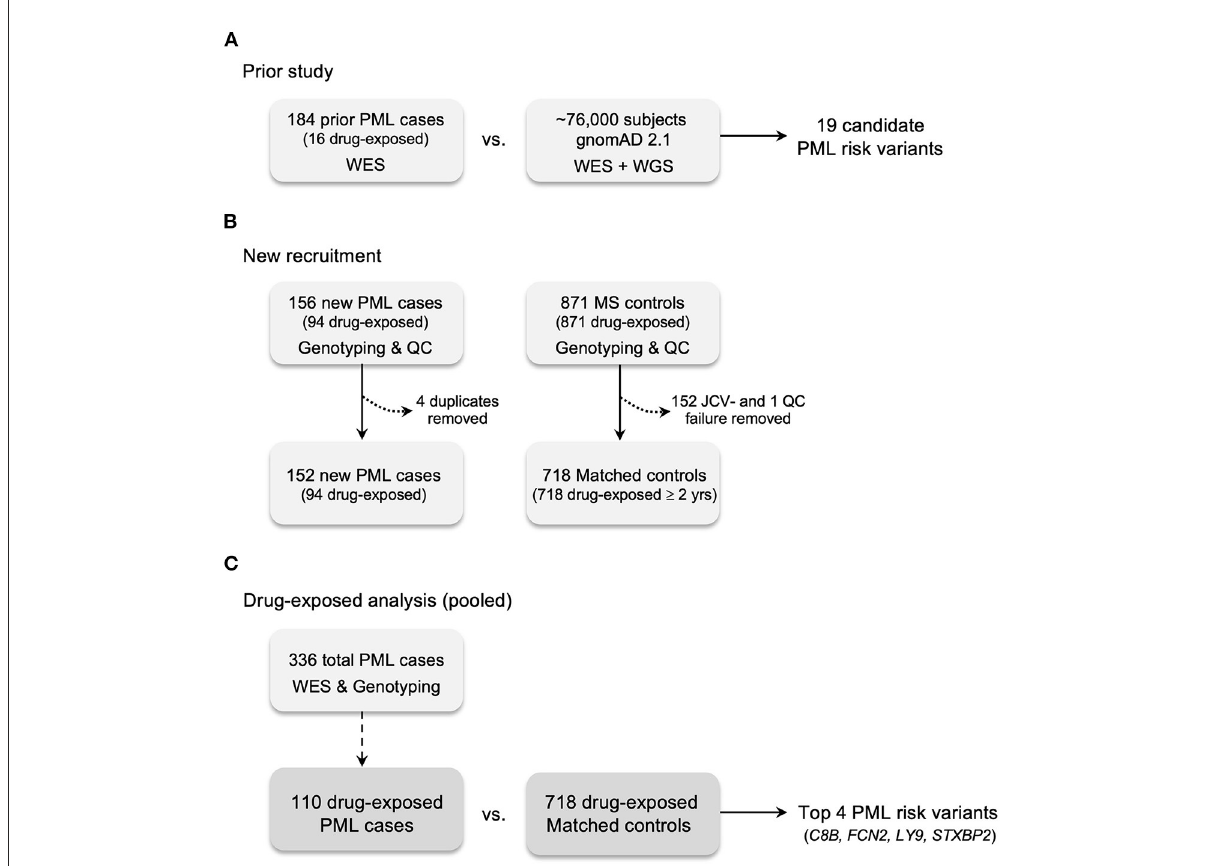
FIGURE1 Case and control recruitment and study design. (A) Prior study for genetic discovery and validation using Whole Exome Sequencing (WES), 669 candidate immune response genes, and gnomAD 2.1 (WES + WGS) population controls (45). (B) New recruitment of PML cases and matched controls (JCV + MS patients exposed to a PML-linked drug ≥ 2 years). All PML cases and matched controls were genotyped for the prior study’s 19 candidate PML risk variants. Matched controls without JCV serostatus were assayed (see Methods). Excluded cases: four were found to be duplicates of the prior study (see Methods). Excluded controls: 152 JCV seronegative (JCV-) patients; one QC failure for genotyping assays due to low quality DNA. (C) Drug-exposed analysis is the pooled subgroup ( n = 110) of total PML cases ( n = 336) compared to matched controls. Drug-exposed study results are reported in Tables 2, 5 and genes for the top 4 variants are